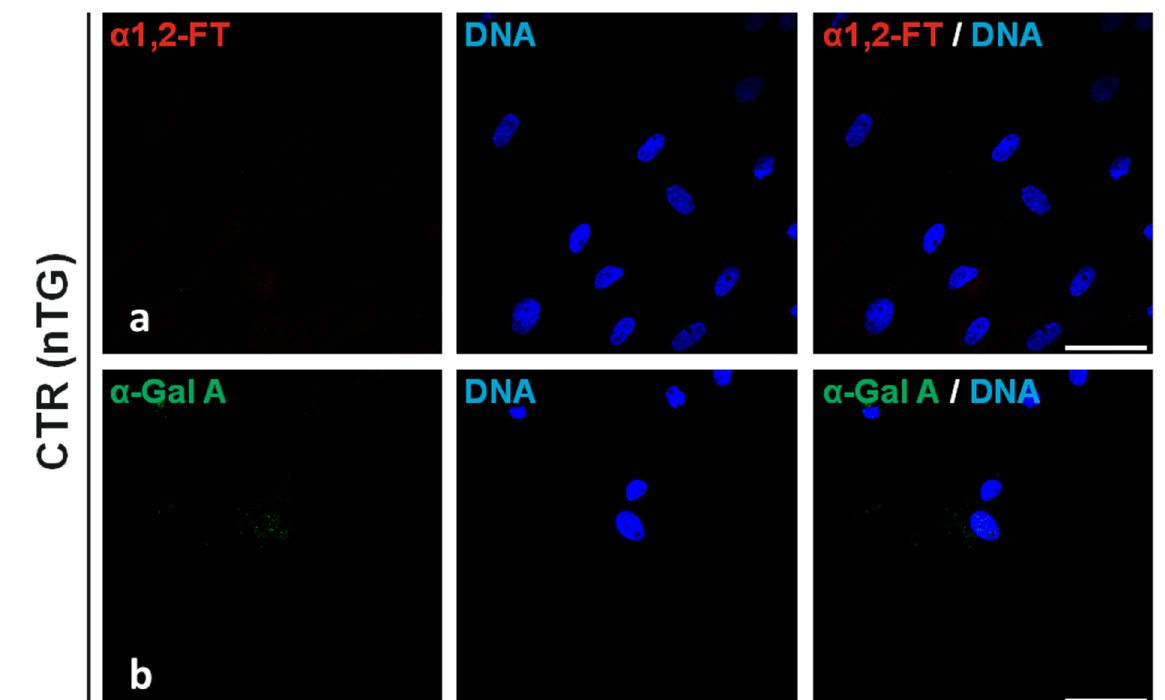
Figure 2. Immunofluorescence analysis of ex vivo-expanded PEKs stemming from control nontransgenic pigs (CTR nTG). Representative microphotographs depicting the immunofluorescent detection of α 1,2-FT-related ( a ) and α -Gal A-related ( b ) locations identified in nontransgenic PEKs. Immunostaining with red Cy3 fluorochrome-tagged or green Alexa Fluor 488 fluorochrome-tagged secondary antibodies and blue fluorescent nuclear counterdyeing with the use of 4 ′ ,6-diamidino-2-phenylindole (DAPI). Scale bars represent 100 μ m. No positive signaling points descended from either xenogeneic rh α 1,2-FT or endogenous species-specific α 1,2-FT were recognized ( a ), while sporadic incidence of hardly detectable spots correlated with immunofluorescently labelling the α -Gal A enzymes was noticed ( b ).